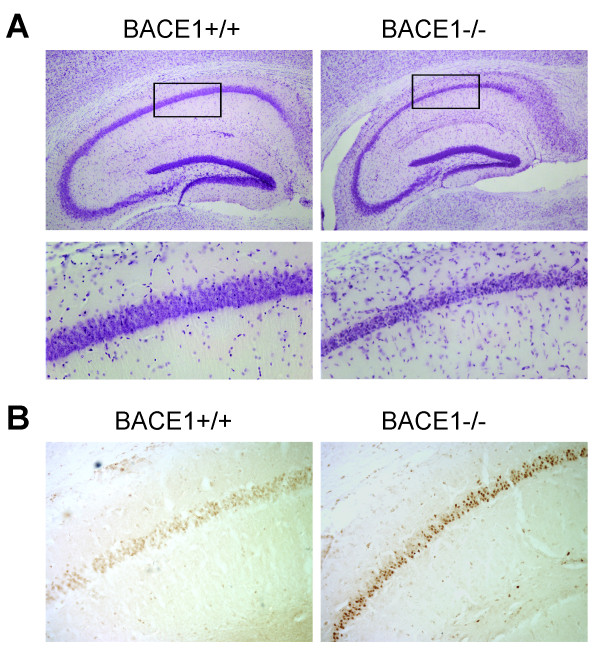
KA-induced cell death in BACE1-/- mice. Mice were injected with 20 mg/kg of KA and recovered for 7 days before brains were harvested and sectioned. A. Cresyl violet staining reveals extensive degeneration in the CA1/2 region of the hippocampus in some BACE1-/- mice (right) but no BACE1+/+ littermates (left). 3 of 10 BACE1-/- mice had cell loss as demonstrated. 0 of 7 wild-type mice had cell loss. Lower panels are higher magnification images of region indicated by box in upper panels. B. TUNEL staining performed on adjacent sections indicates DNA fragmentation in many cells of the CA1/2 region in 3 of 10 BACE1-/- mice (right). No TUNEL-positive cells were seen in any of 7 KA-treated wild-type littermates (left) nor in BACE1-/- mice that lacked cell loss.